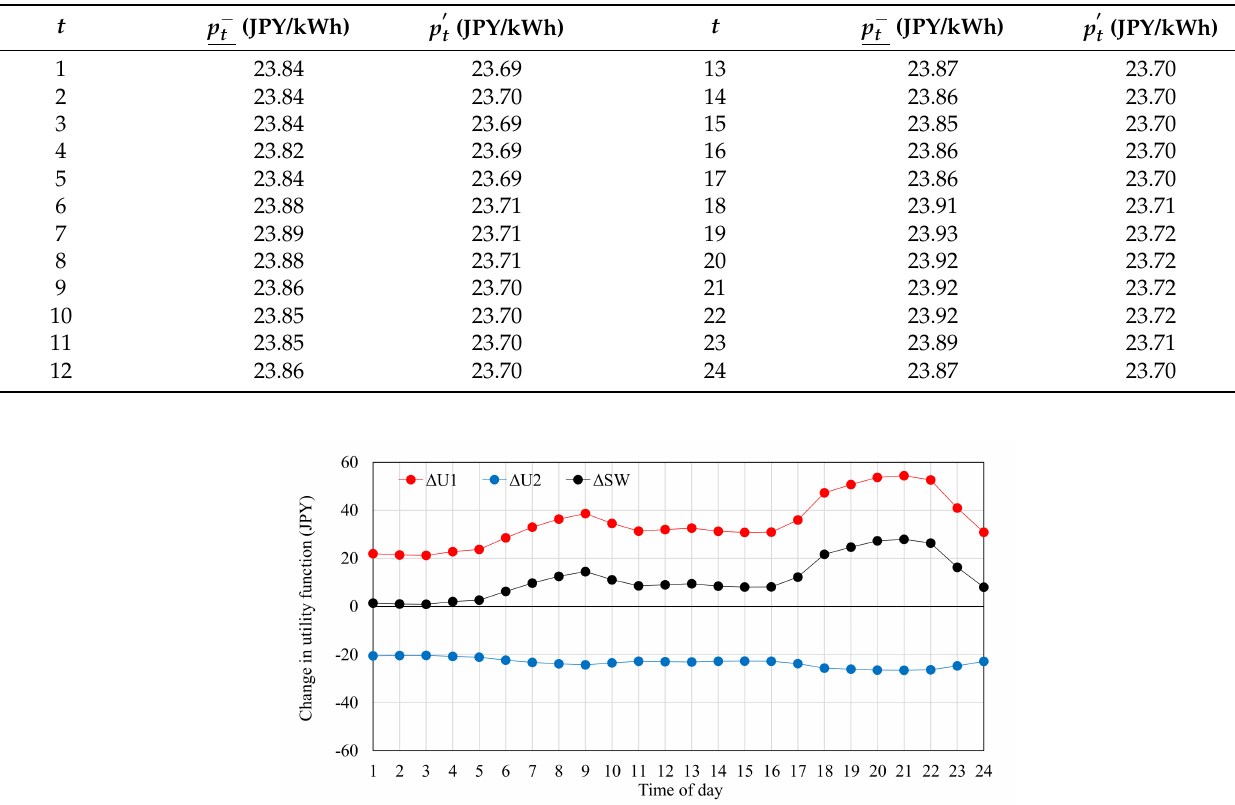
Table 5. Numerical simulation results of price-based DRs under scenario 2.